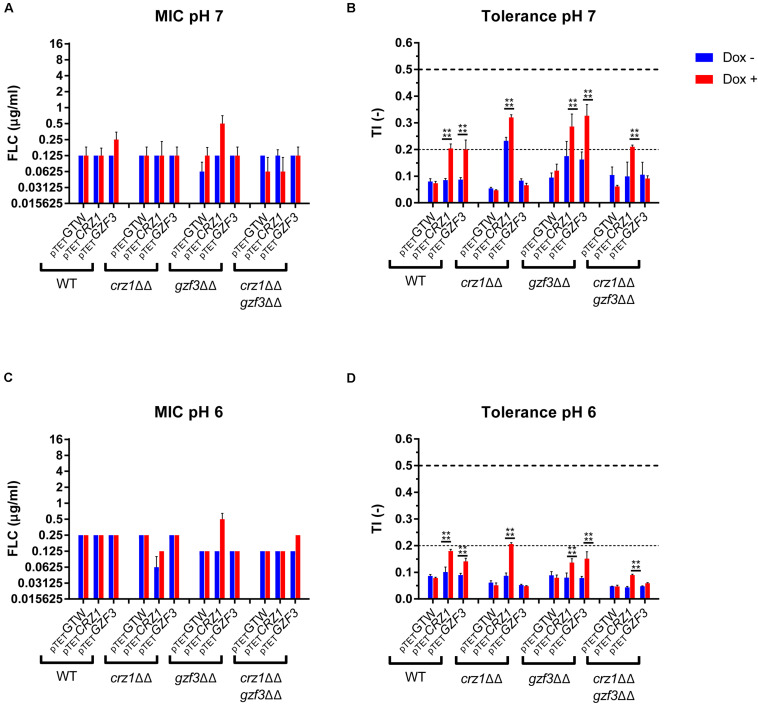
Susceptibility profile of the CRZ1 and GZF3 mutants overexpressing either CRZ1, GZF3. (A,C) Susceptibility to FLC is represented as the modal MIC value with standard deviation calculated on the mean MIC of all replicates. (B,D) Tolerance profile of the mutant strains. The mean TI and standard deviations are represented. Horizontal dashed lines represent the lower threshold of tolerance (TI = 2), and the upper limit of susceptibility (TI = 0.5) as described by EUCAST. Each data set represents the mean (or mode) of biological duplicates. Statistical significances (B,D) were estimated using Sidak’s multiple comparison tests (two-way ANOVA, 95% confidence interval) between Dox– and Dox+ conditions in the same mutants set. P-values: (****) ≤ 0.0001. Supplementary Table S1 lists correspondence between genotype and strain number.